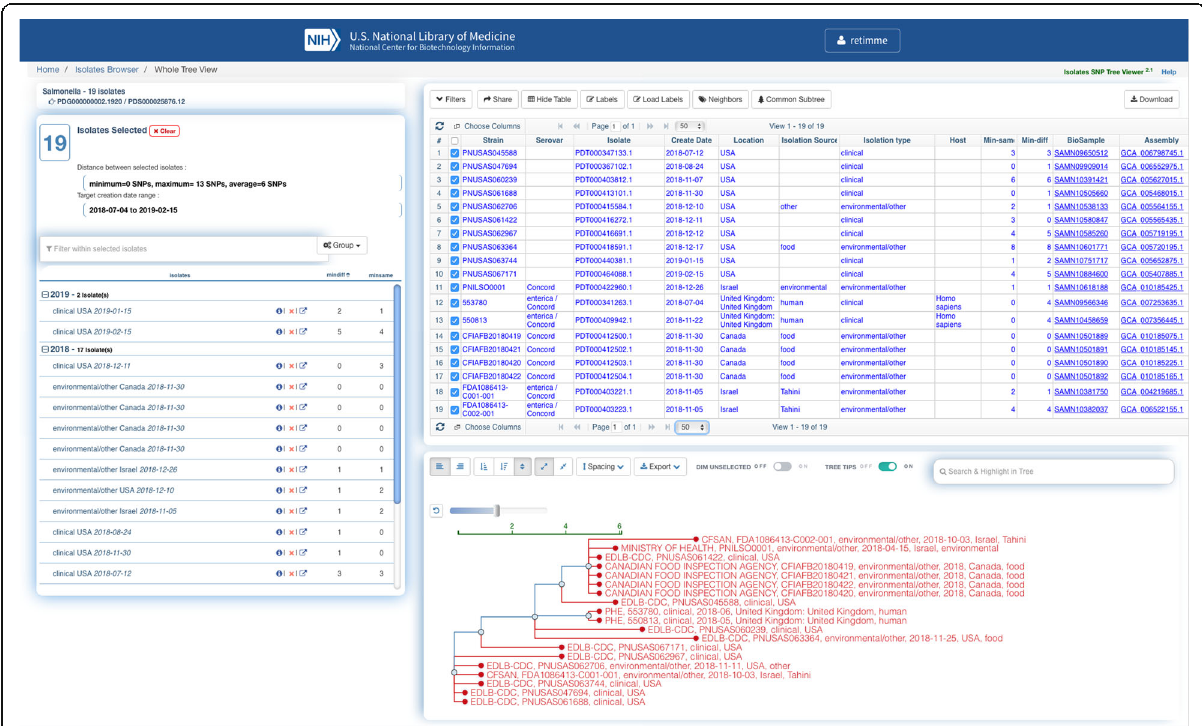
Fig. 2 Screen shot of a cluster within the NCBI-PD browser showing harmonized metadata submissions across five different submitting laboratories (PulseNet, GenomeTrakr, Public Health England, Israel Ministry of Health, and CA Food Inspection Agency). URL: https://www.ncbi.nlm.nih.gov/Structure/tree/#!/tree/Salmonella/PDG000000002.1922/PDS000025876.12?treelabel=sra_center,strain,epi_